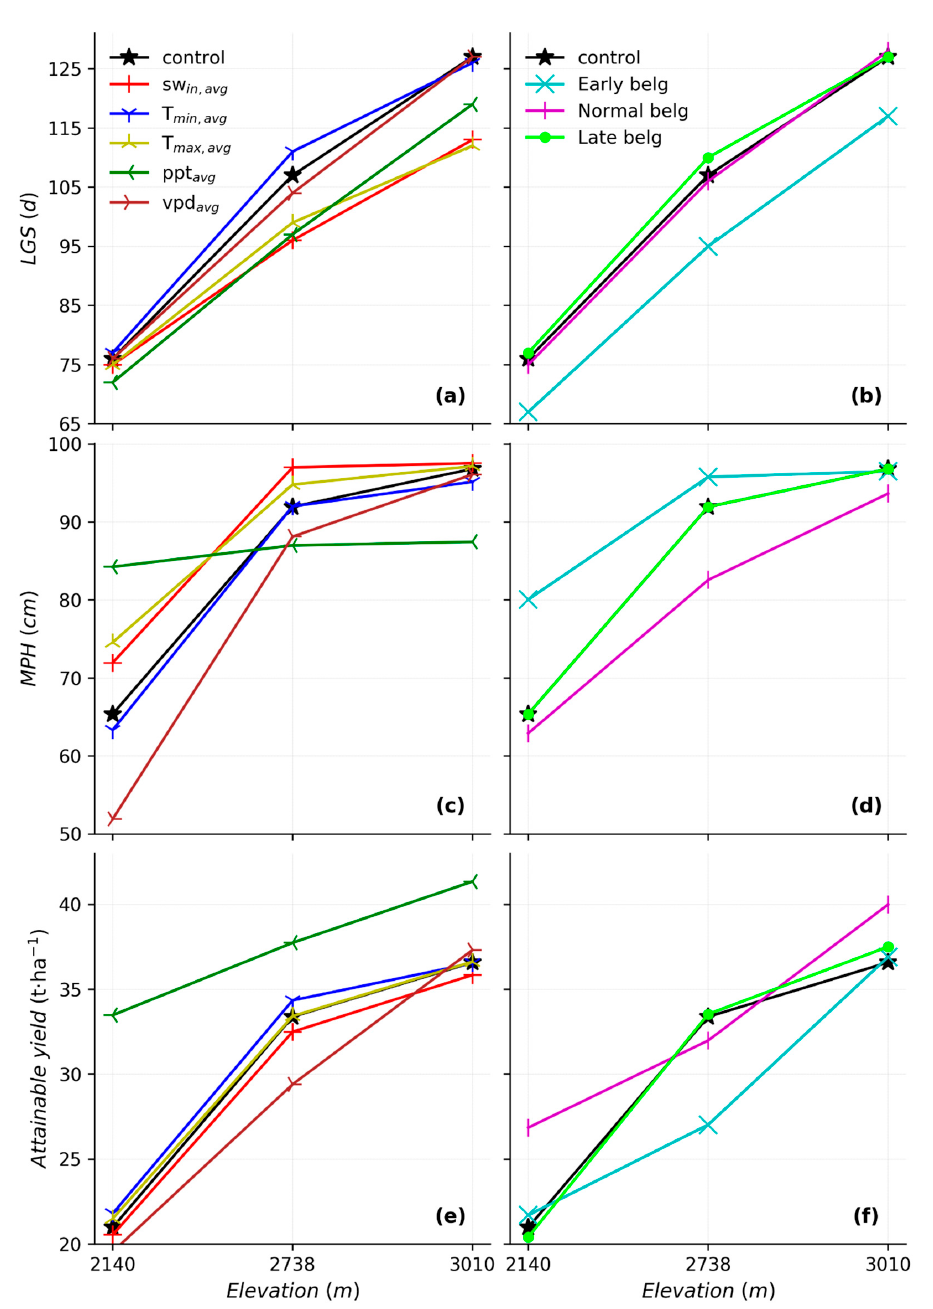
Figure 10. Model sensitivity experiment outputs based on Table 3 for Tegecha (2140 m), Chencha (2738), and Gircha (3010) stations. The LGS (d) ( a , b ), MPH (cm) ( c , d ), and attainable yield (t ∙ ha − 1 ) ( e , f ). The left panel shows average distribution (means of the belg data for each day) experiments of the major atmospheric crop drivers: SW ↓ , T min , T max , PPT, and VPD. The right panel shows shifting the peak precipitation in May to March (“Early belg ”), April (“Normal belg ”), and June (“Late belg ”) model experiment assumptions. Note that the control experiment is added in each panel for ease of comparison.